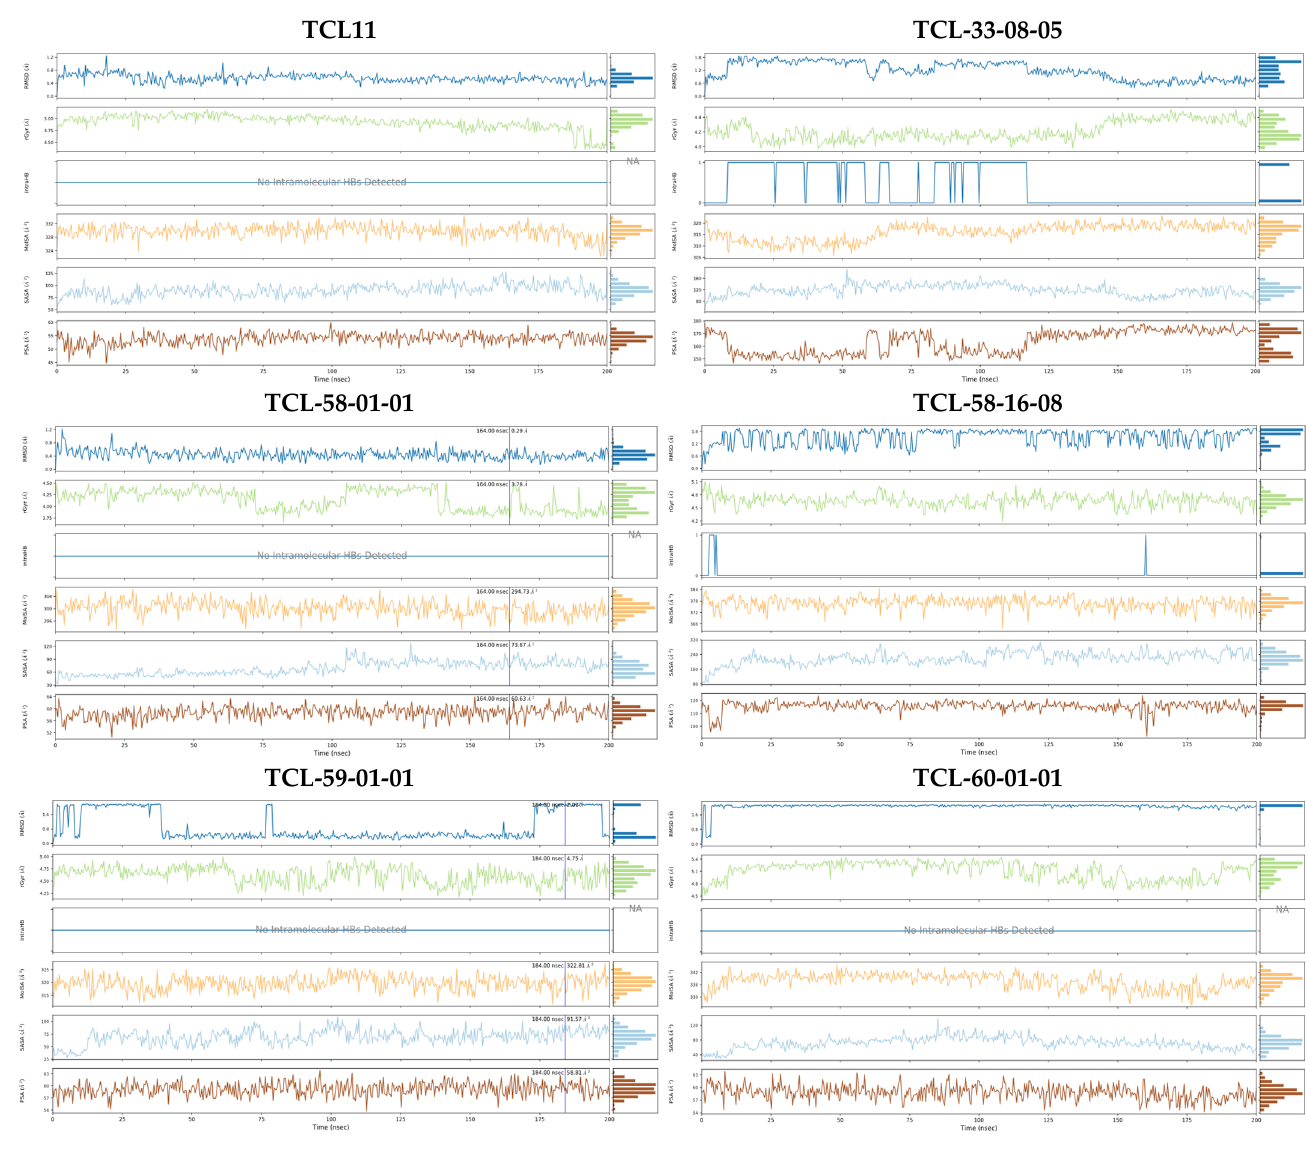
Figure 10. Time-evolution of the properties of the six Pf ENR-TCLx complexes during 200 ns MD simulation. For each inhibitor, top to bottom: plot of the root mean square deviation (RMSD) with respect to the initial conformation vs. the simulation time, radius of gyration (rGyr), number of intramolecular hydrogen bonds (intraHB), molecular surface area (molSA), solvent-accessible surface area (SASA), and polar surface area (PSA).